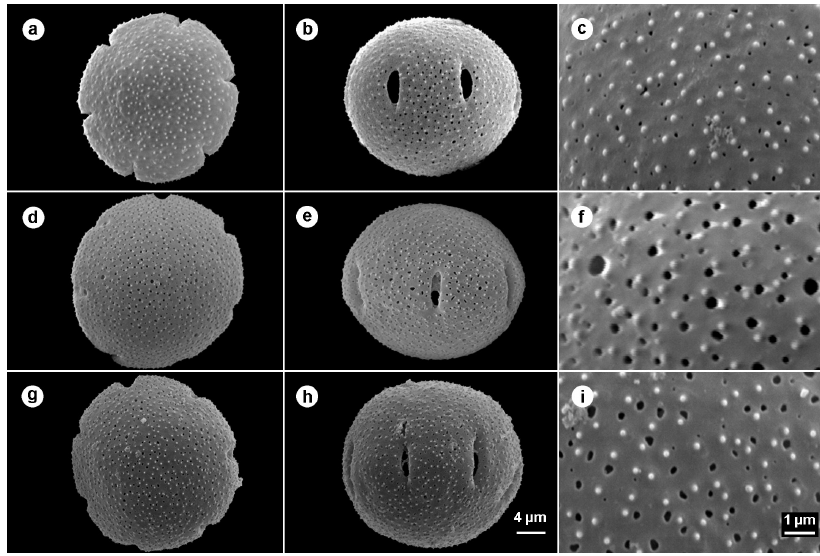
Figure 3 - Pollen morphology. a - c . Diacrodon compressus, a . Polar view; b . Equatorial view; c . Detail of the exine; d - f . Borreria spinosa , d . Polar view; e . Equatorial view; f . Detail of the exine; g - i . Borreria verticillata , g . Polar view; h . Equatorial view; i . Detail of the exine. Scales: a - b , d - e , g - h 4 µm (on h ); c , f , i 1 µm (on i